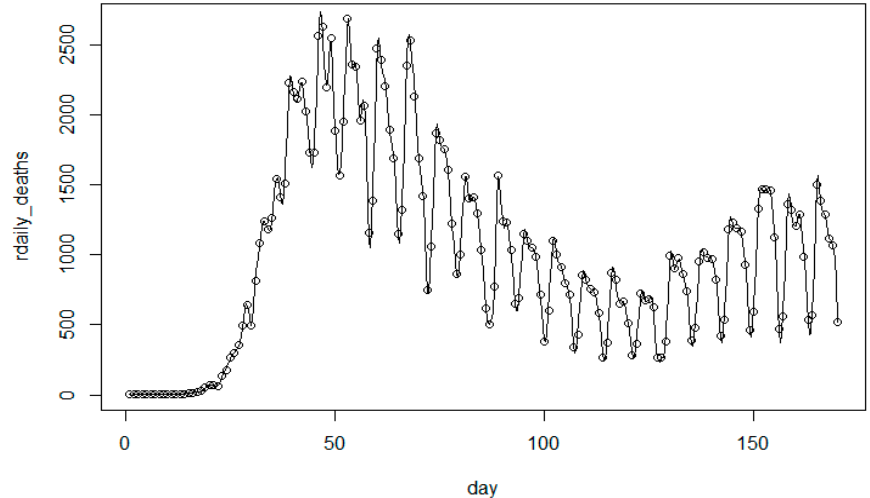
Figure 2. Daily number of deaths over time for the United States.